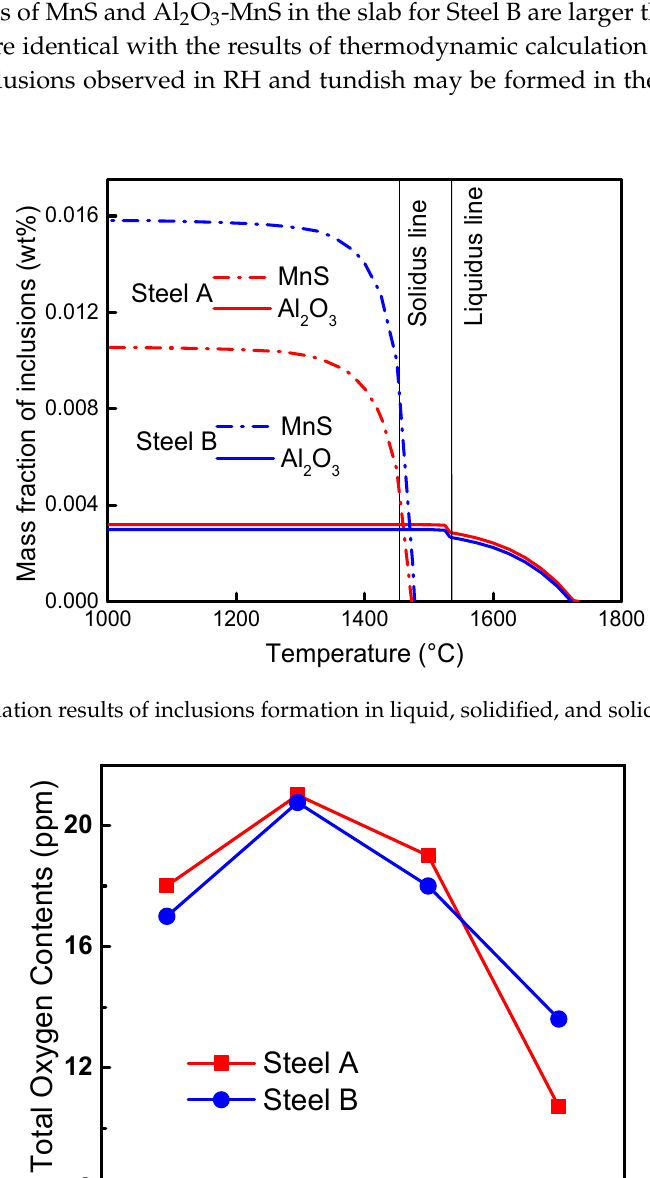
Table 1. Chemical compositions of the steels (mass%).